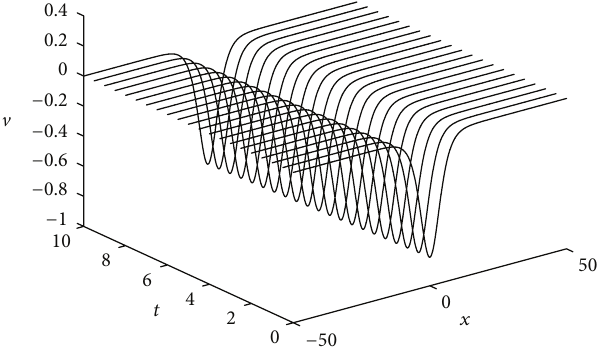
Figure 3: The evolution of the numerical solution of real part of 𝑢 and 𝜖 = 8.0 .